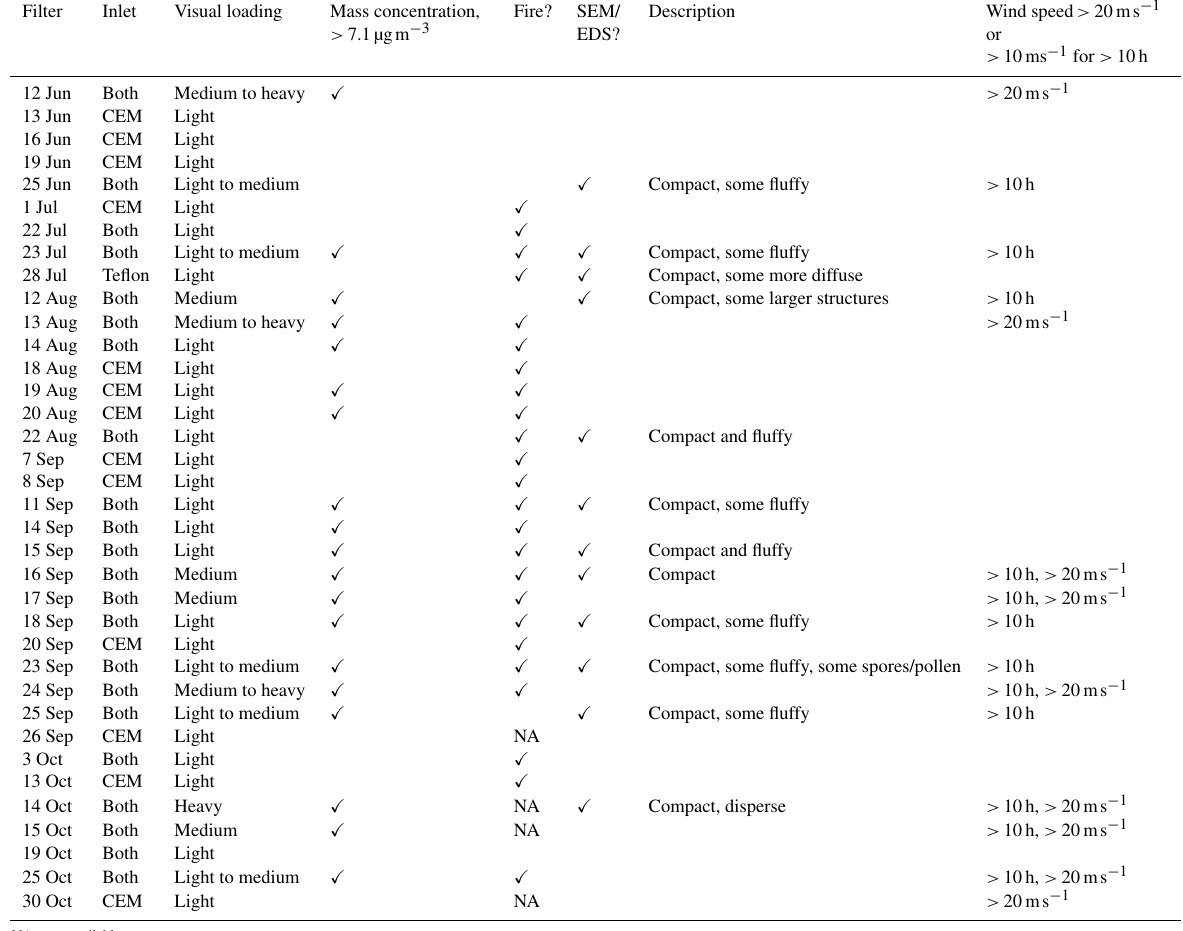
Table 1. Days at PEAV in 2014 with visible aggregates on filters, the inlet with aggregates (CEM – cation exchange membranes, Teflon filters, or both inlets), the loading on the filters, whether PM 2 . 5 mass concentration exceeded 75th percentile value for the sample period (7.1µgm − 3 ), presence of fire flag, scanning electron microscopy (SEM) and energy dispersive X-ray spectroscopy (EDS) analysis, subjective description of the shape, and whether wind speed exceeded 20ms − 1 for at least one hour of the sample day or wind speed exceeded 10ms − 1 for 10h or longer leading up to or during the sample